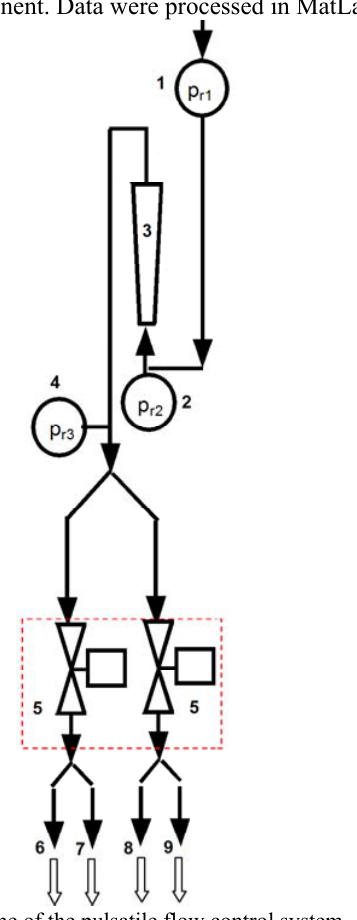
Fig. 3 . Scheme of the pulsatile flow control system